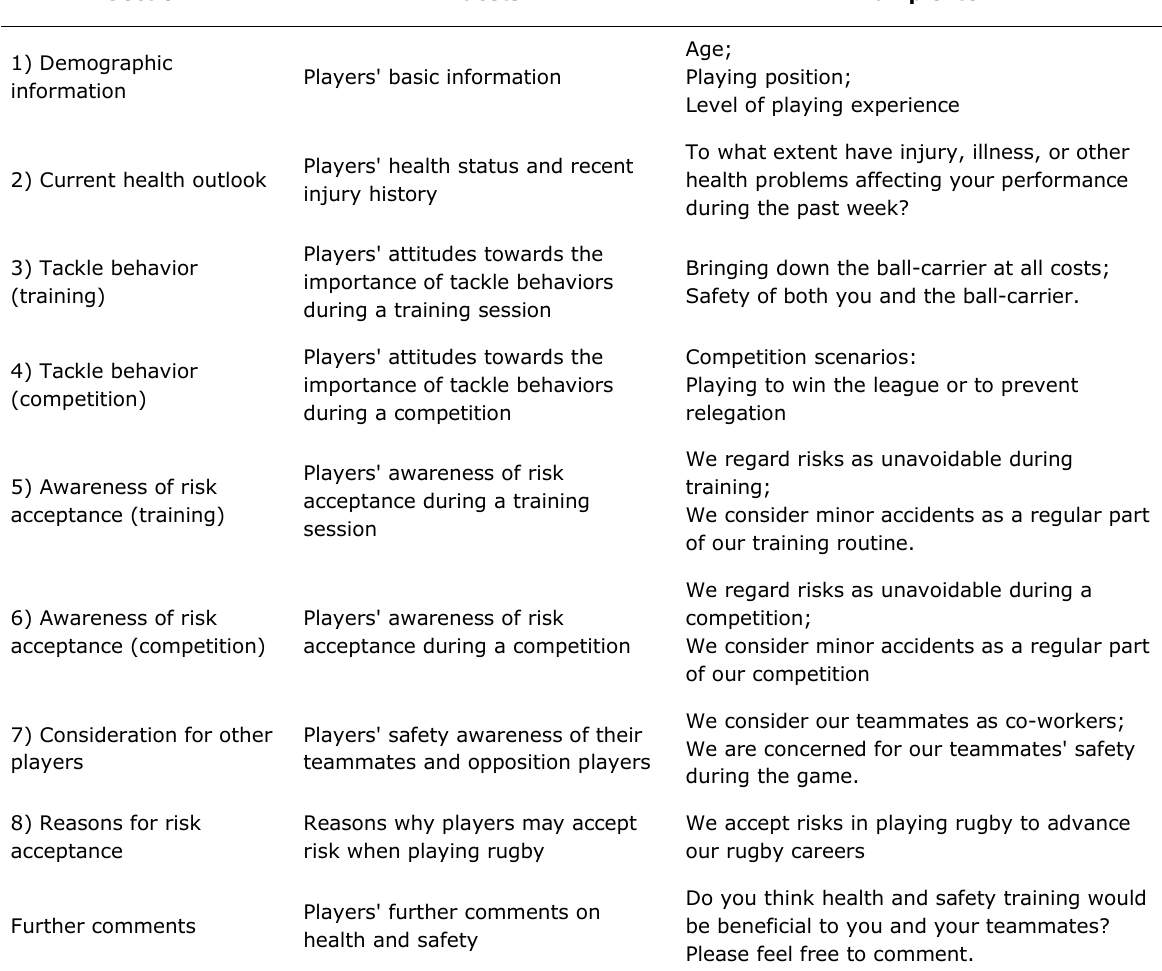
Table 1. Survey safety and risk awareness section, facets and exemplifying items Section Facets Example